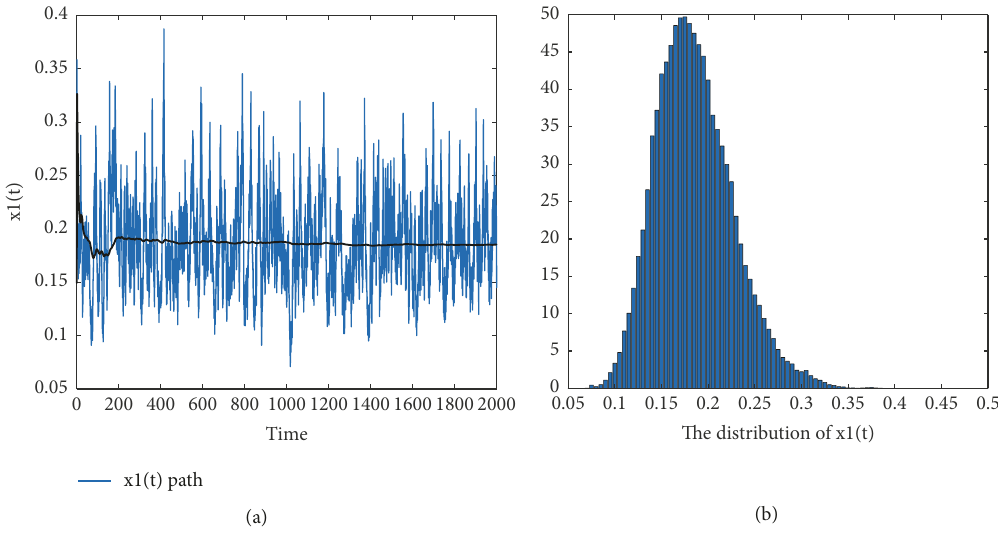
Figure 4: (a) is the time series of 𝑥 1 (𝑡) with initial value 𝑥 1 (0) = 0.3 ; (b) is the distribution interval of 𝑥 1 (𝑡) .